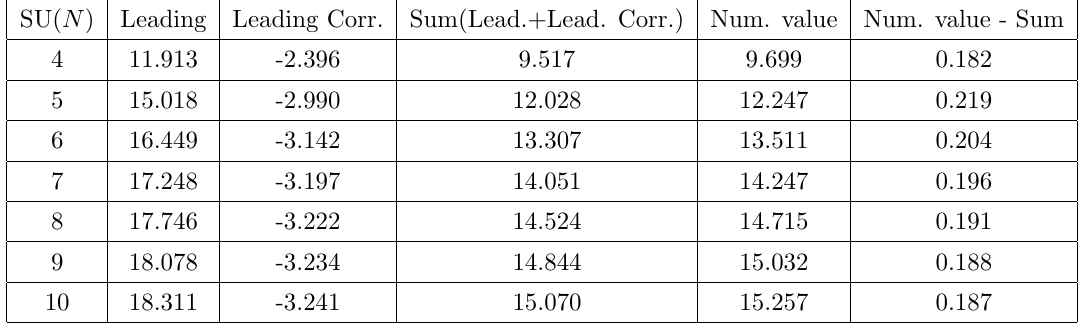
Table 10 . Comparison of N -ality 3 k -strings for SU(4